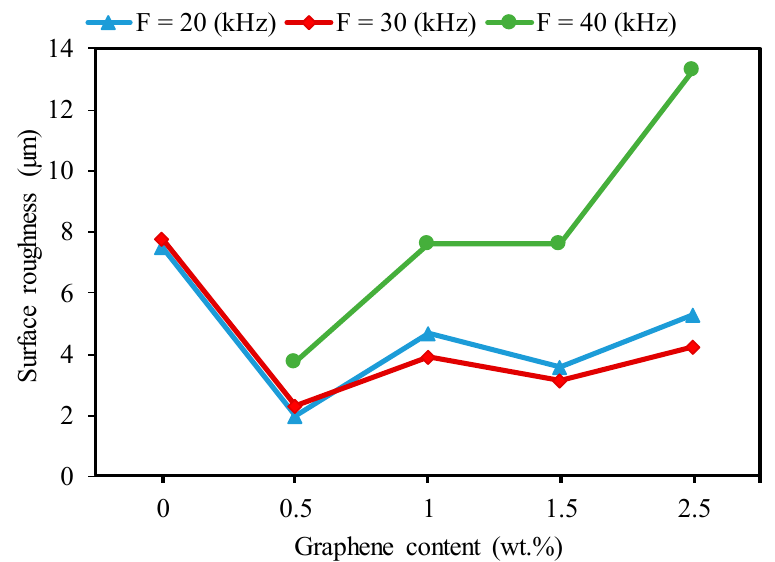
Figure 19. Effects of the graphene reinforcements and frequency on surface roughness during the micro-milling of the base Al 2 O 3 and GNP/Al 2 O 3 nanocomposites (SS = 300 mm/s) . In general, it can be seen in Figure 19 that the surface roughness trend increased as the frequency increased from 20 kHz to 40 kHz for the 0.5 wt.% GNP/Al 2 O 3 . The low laser energy caused more unmolten materials to be deposited at the bottom of the fabricated microchannels, which affected the roughness of the ablated surface [40,49]. In addition, Figure 20 shows that the roughness decreased by increasing the frequency to 30 kHz from 20 kHz in the case of the 1 wt.%, 1.5 wt.%, and 2.5 wt.% GNP/Al 2 O 3 . This was expected due to their higher thermal resistance, smaller grain size, and lower light transmittance compared to the 0.5 wt.% GNP/Al 2 O 3 . At the frequency of 20 kHz, excessive energy was generated, and more materials were molten and evaporated, which led to a redeposit of molten material on the surface [49]. Figure 20. Effects of varying graphene contents with laser speed on MRR. At F = 30 kHz.